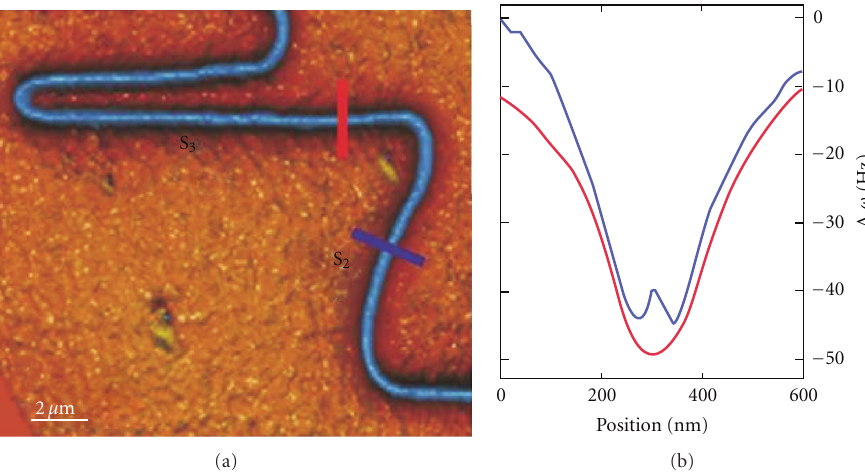
Figure 8: (a) Electric force microscopy (EFM) image of the same SWNT serpentine discussed in Figure 6. (b) Scanning across the SWNT, the cantilever frequency shift is di ff erent if a tube is semiconducting (“W shaped” blue line) or metallic (“V shaped” red line) [57]. The red and blue lines in (a) indicate the two regions where these profiles in (b) were acquired